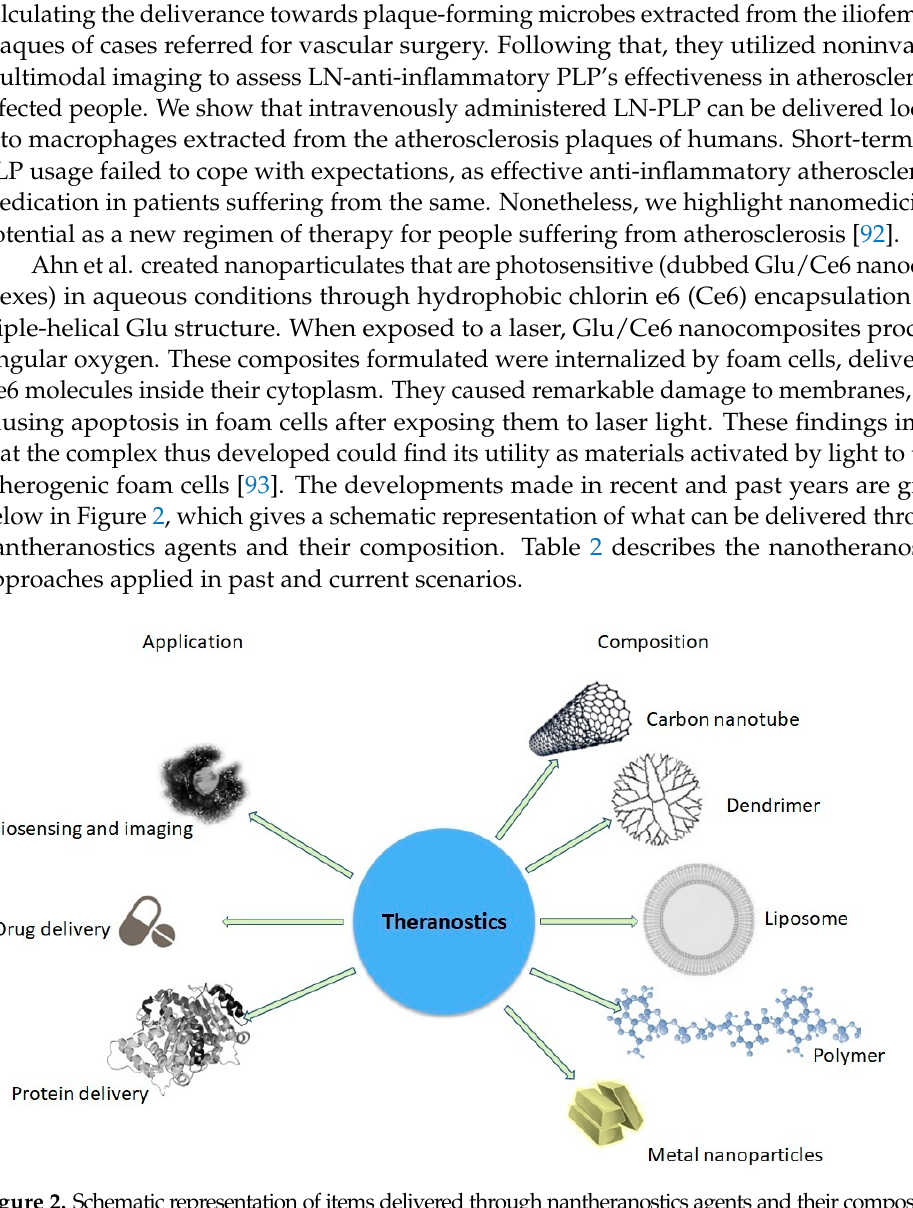
Figure 2. Schematic representation of items delivered through nantheranostics agents and their composition.